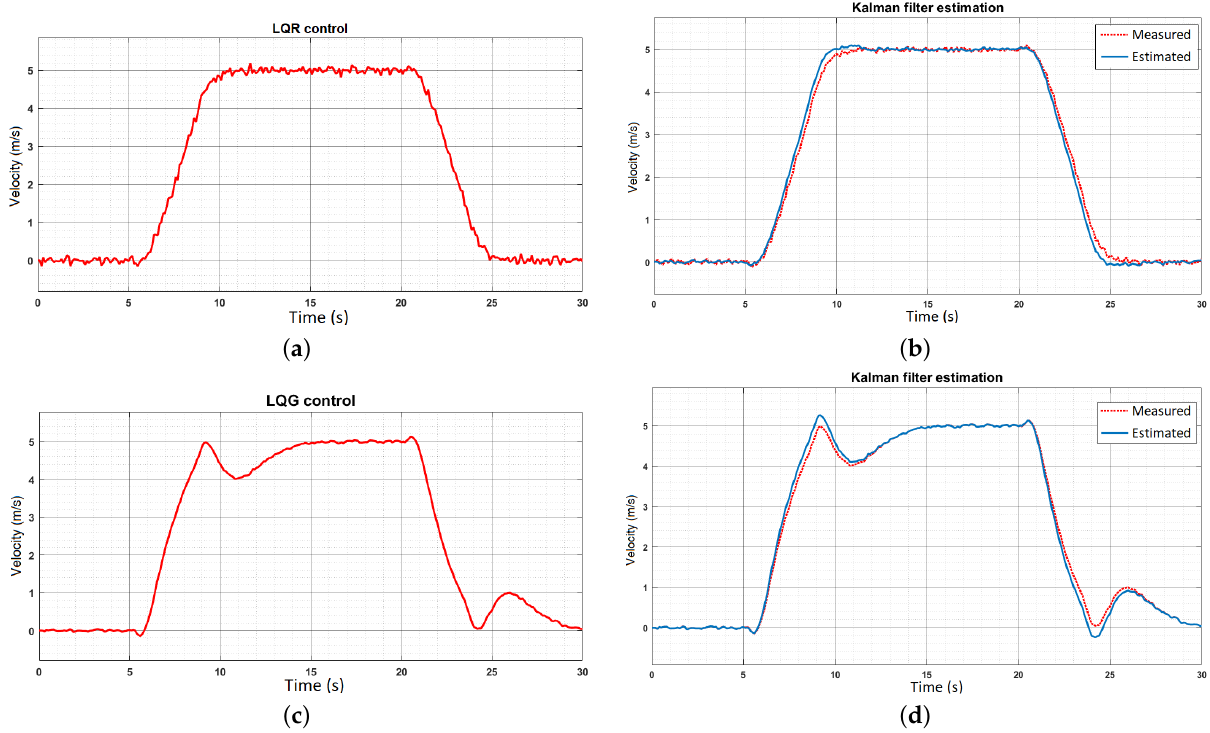
Figure 12. Velocity responses with LQR and LQG control. ( a ) Velocity response with LQR control. ( b ) Velocity estimation during LQR control. ( c ) Velocity response with LQG control. ( d ) Velocity estimation during LQG